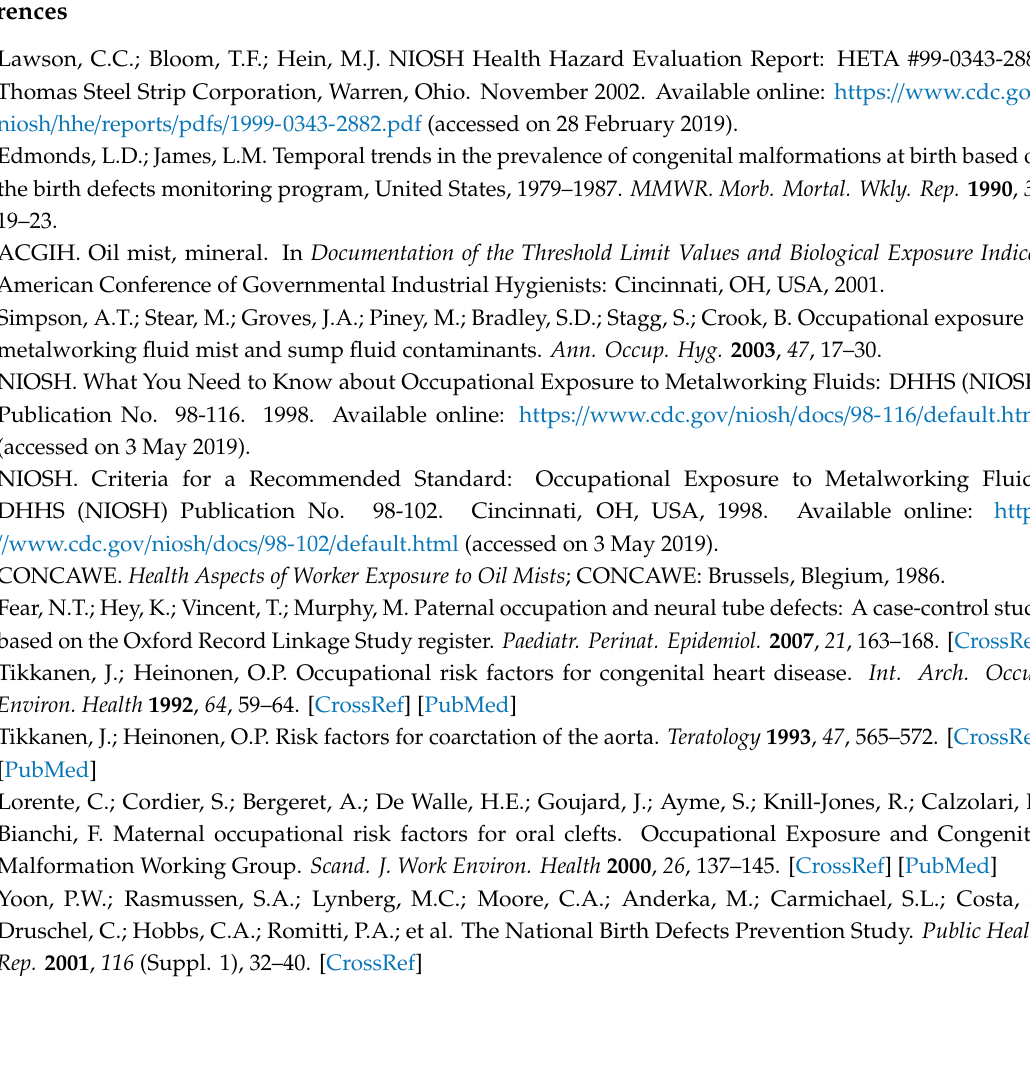
Table S1: Demographic characteristics of mothers occupationally exposed and unexposed to oil mists in early pregnancy, NBDPS 1997–2011, Table S2: Crude and adjusted associations between maternal occupational oil mist exposure in early pregnancy and (simple) isolated or multiple birth defects, NBDPS